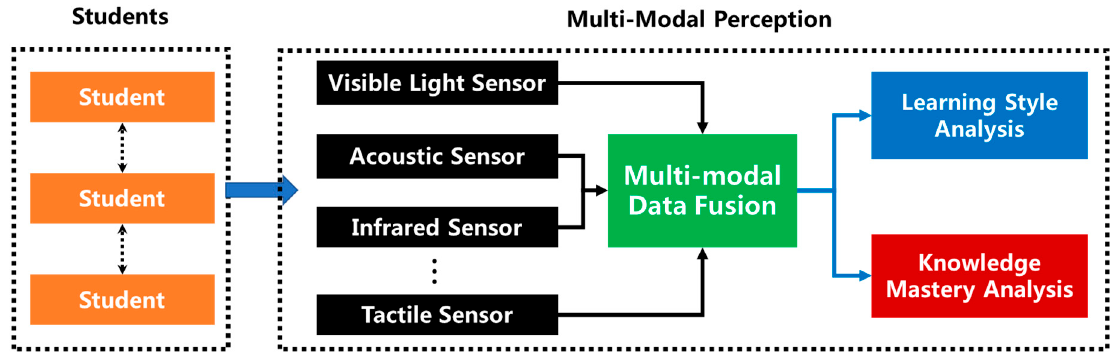
Figure 2. Architecture of multi-modal perception with data fusion and analysis.